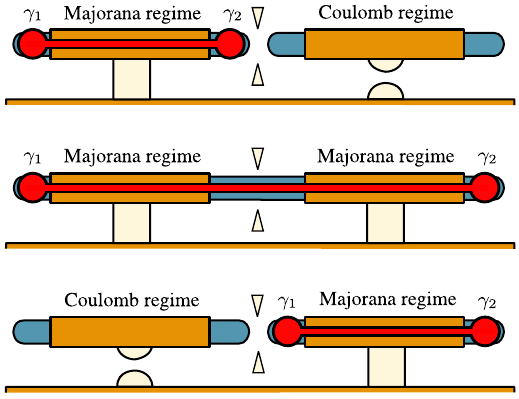
FIG. 17. Two-step protocol for moving Majoranas γ 1 and γ 2 from the left island, initially tuned to the Majorana regime, to the right island, initially tuned to the Coulomb regime with even parity. First, the two islands are coupled by increasing the transmission to τ ¼ 1 and tuning the right island to the Majorana regime, shuttling γ 2 to the right island. The two islands now form a single connected superconducting island with Majoranas γ 1 and γ γ 2 . In order to move 1 to the right island, the transmission is reduced back to τ ¼ 0 , and the left island is tuned to the Coulomb regime.